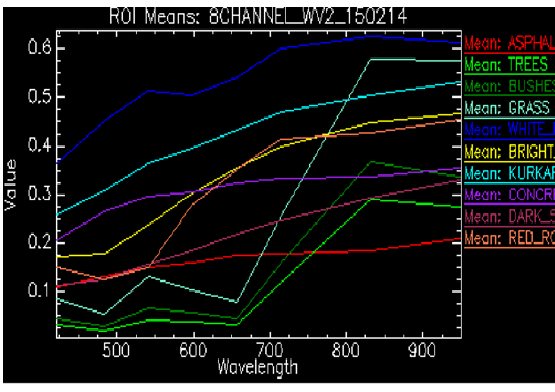
Figure 3. Mean spectral signature for each land cover